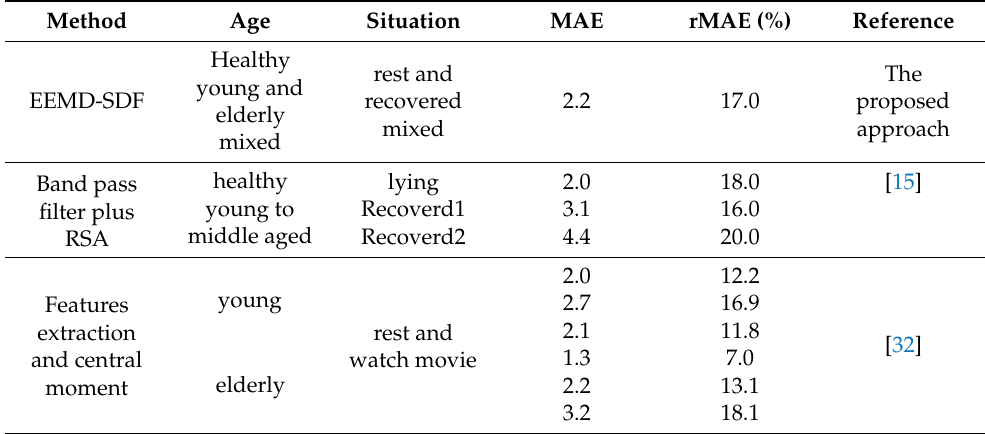
Table 6. The comparison of RR using EEMD-SDF and other methods in MAE and rMAE.